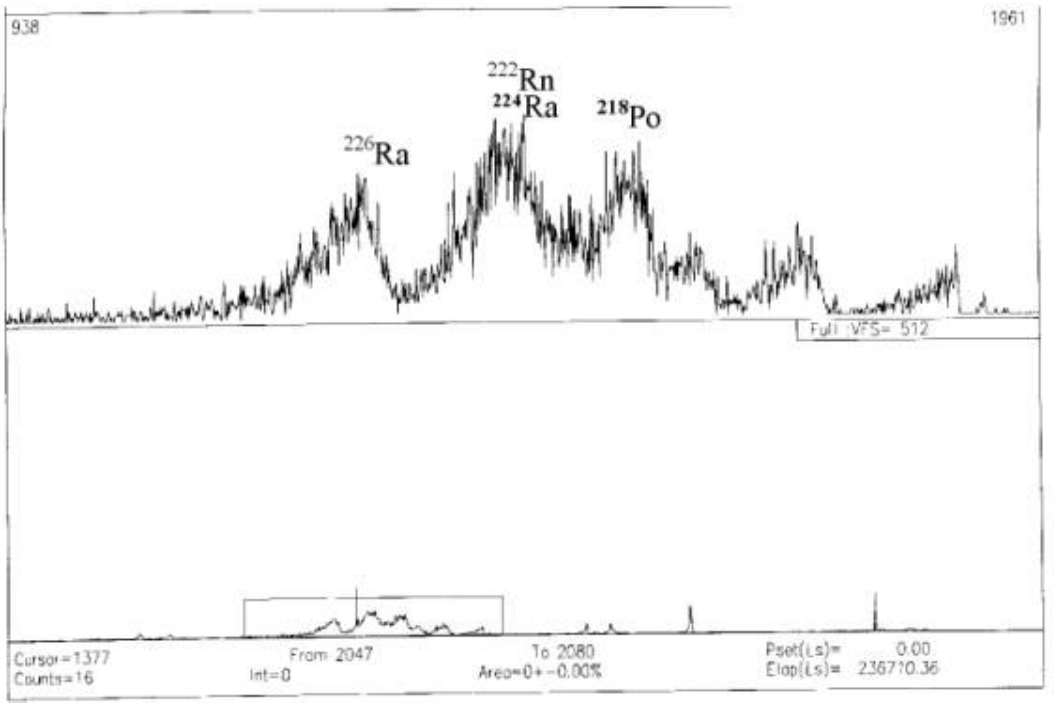
FIGURE 3B . Spectrum for the same sample measured 3 weeks after source